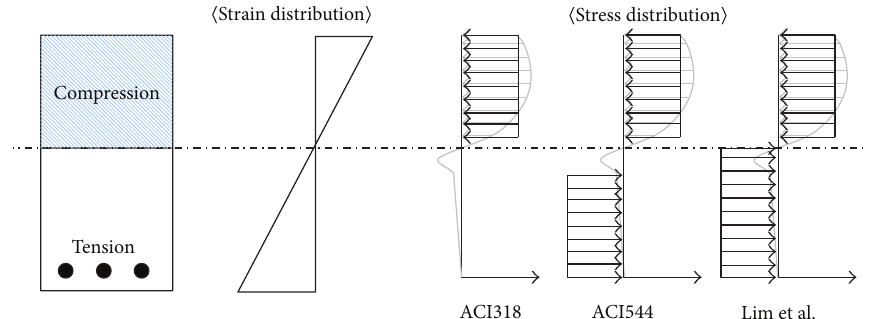
Figure 1: Previously suggested stress block combination.